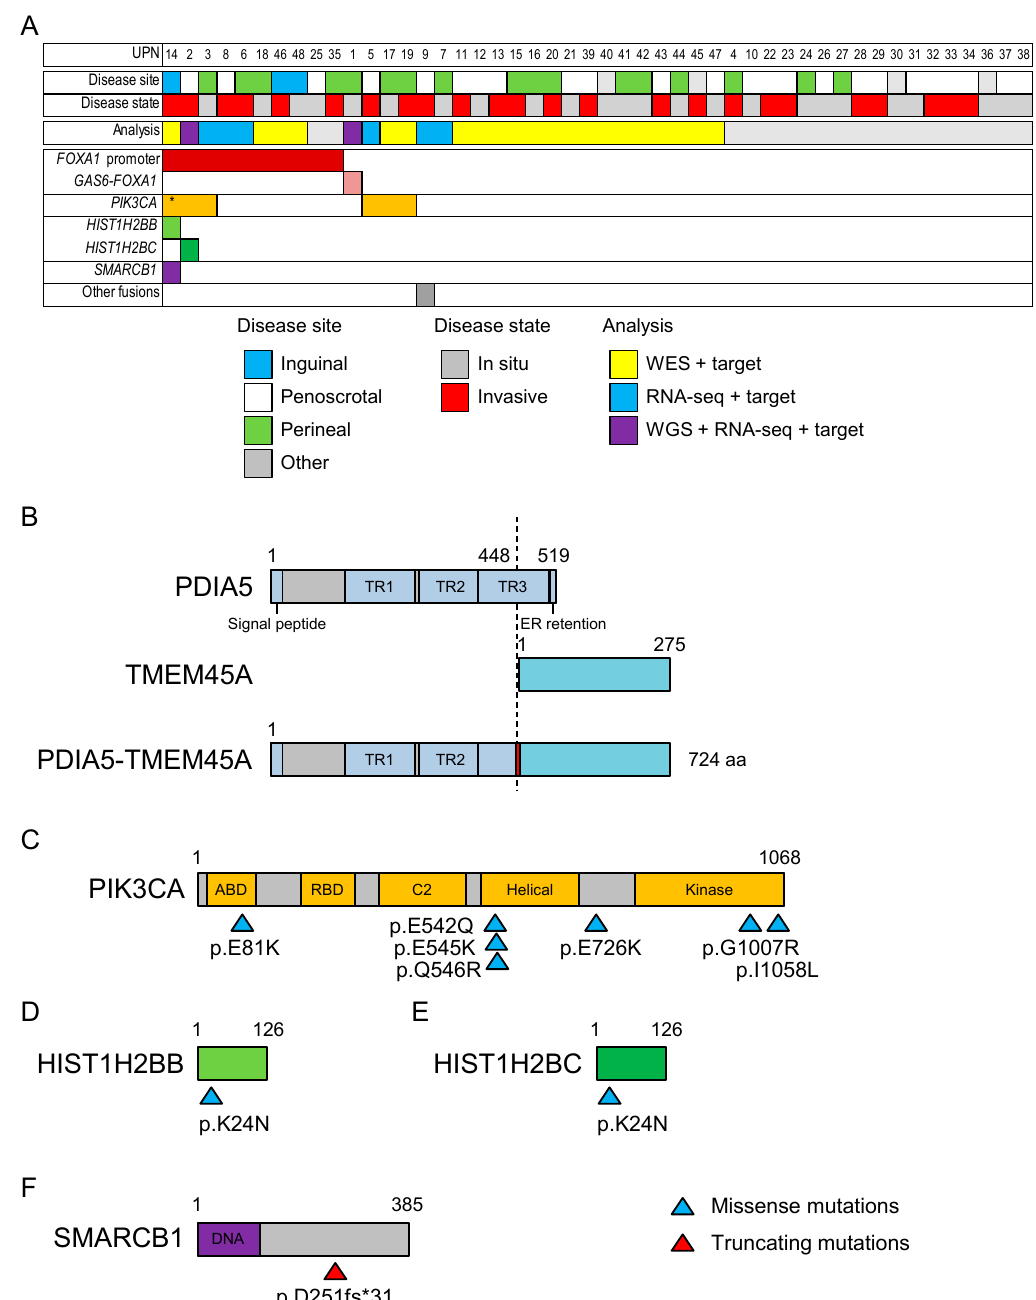
Figure 2. Summary of somatic mutations in EMPD. ( A ) The mutational landscape of EMPD. Yellow, blue, purple, and gray indicate patients analyzed by whole-exome sequencing (WES) plus targeted sequencing, RNA sequencing (RNA-seq) plus targeted sequencing, whole-genome sequencing (WGS) plus RNA-seq plus targeted sequencing, and targeted sequencing, respectively. Boxes with colors indicate the presence of mutations. An asterisk indicates two coexistent PIK3CA mutations within a patient. ( B ) Predicted protein structure of the PDIA5–TMEM45A fusion gene identified in UPN9. Amino acid residues 1–448 of PDIA5 and 1–275 of TMEM45A are connected by an additional isoleucine residue between them (indicated by red). TR, thioredoxin domain; ER, endoplasmic reticulum. ( C – F ) The distribution of somatic mutations in affected genes. Blue and red triangles indicate missense and truncating mutations, respectively. Numbers indicate amino acid numbers. ABD, p85-binding domain; RBD, Ras binding domain; C2, C2 PI3K-type domain; DNA, DNA binding domain.